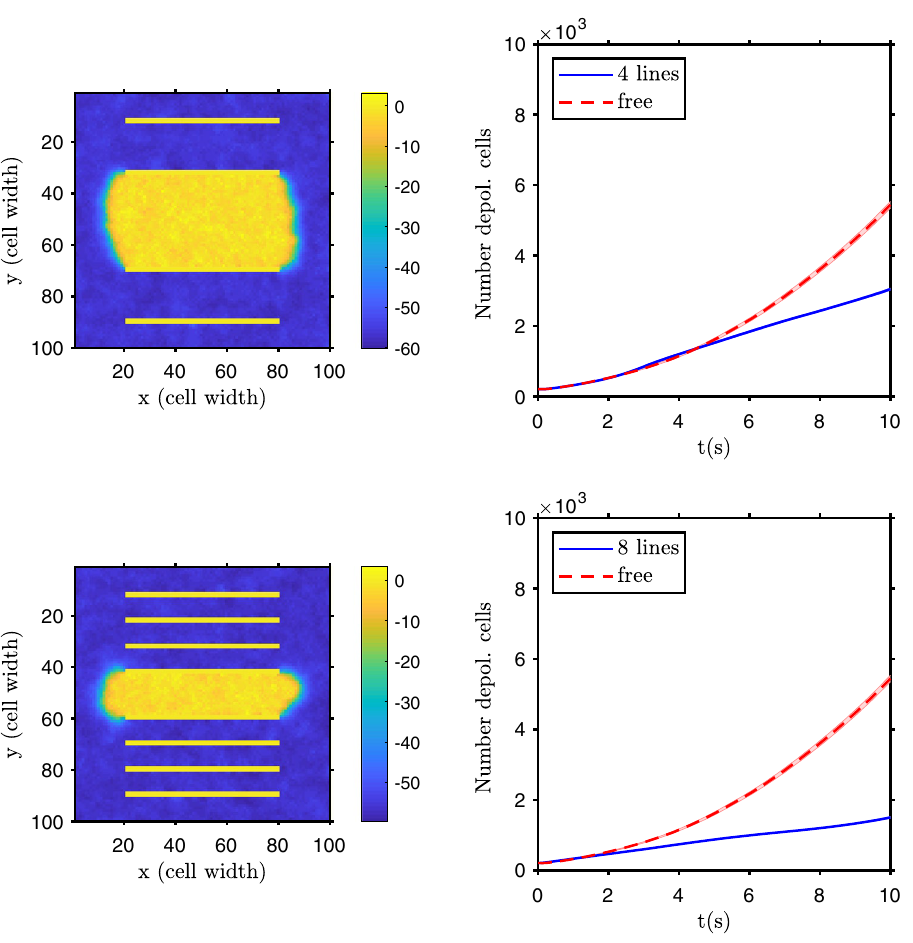
Figure 6. Effect of electrical isolating obstacles. Example of the two-dimensional domain polarization state after 10 seconds (left column, yellow corresponds to depolarized cells and blue to polarized ones) and the evolution of the number of depolarized cells (right column) for a domain with 4 isolating walls (top row, yellow horizontal bands) and with 8 isolating walls (bottom row). Initially all the cells were depolarized and an initial circular depolarized patch, with R = 8 cells’ width, is placed on the center of the domain. The bands show the standard deviation of the mean of n = 20 simulation runs.